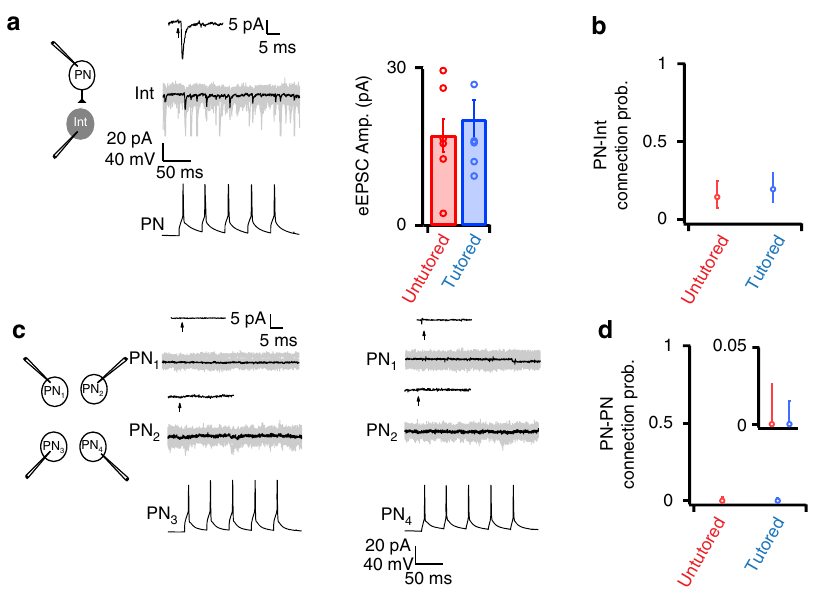
Fig. 4 Excitatory PN synapses were not altered during song learning. a Example PN → FSI connection. Evoked PN spikes (bottom) drove monosynaptic EPSCs in a postsynaptic FSI (middle). The black trace is the average of 30 individual sweeps (overlaid gray traces). PN → FSI connections exhibited modest short-term depression (0.63 ± 0.06 at 50 Hz), as observed in other systems 41 . The black trace above the sweeps is the spike-triggered average (STA) of 375 events to enhance sensitivity to small EPSCs. The arrow indicates the presynaptic spike time. PN → FSI strength did not change during song learning (right panel, n = 10 pairs from 3 untutored birds, n = 17 pairs from fi ve tutored birds). b Tutoring did not alter the probability of PN → FSI connections (0.19 untutored, 0.17 tutored). Error bars indicate 95% con fi dence intervals from a binomial distribution. c Example of quadruple recording from four PNs. Brief current pulses evoked spikes in one PN (bottom), while the other PNs were voltage-clamped at E Cl to detect evoked EPSCs. Gray current traces are 75 overlaid single sweeps and the black trace is the average. We were unable to detect any PN – PN connections in 262 attempts. d Summary of attempts to record PN – PN connections in untutored (red) and tutored (blue) birds. The upper 95% con fi dence interval is 0.026 in untutored birds and 0.014 in tutored